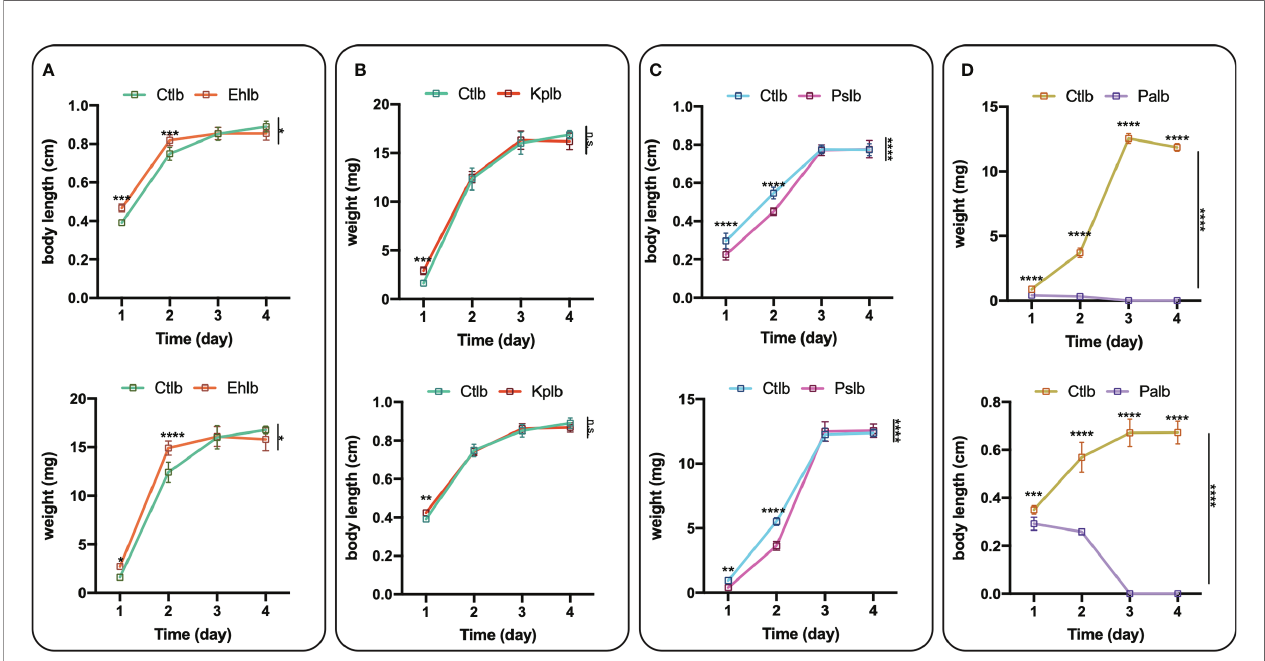
FIGURE 7 | Effects of cultivable bacteria in house fl y larval intestines on larval development. Ehlb (A) , Kplb (B) , Pslb (C) and Palb (D) refer to house fl y larval samples fed diets with E. hormaechei stock solution , K. pneumoniae stock solution, P. stuartii stock solution and P. aeruginosa stock solution, respectively. The data are represented as the means ± SEM. Each treatment included 12 biological replicates. Repeated measures ANOVA was followed by Sidak correction for multiple comparisons. * P < 0.05, ** P < 0.01, *** P < 0.001, **** P < 0.0001. n.s., no signi fi